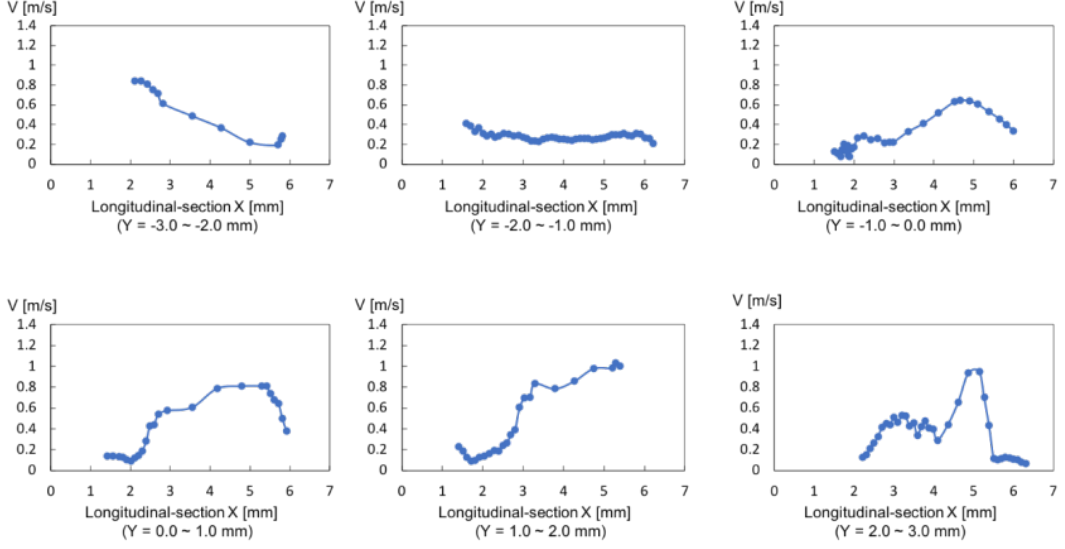
Figure 7. Flow velocity graph around the keyhole in the case of 160 A. Distribution of flow velocity around the ending part (X = 7.0~23.0 mm) in the case of 160 A is shown in Figure 8. The velocity increased from the ending part of the melted domain toward the keyhole, especially around X = 7~8 mm. At X = 7 mm, the velocity was very high. This is caused by the inward flow from the ending part of the weld pool until the keyhole and in downward flow from the upper side toward the lower side of the melted region. At Y = − 3.0~ − 2.0 mm region, the velocity was mostly unchanged along the weld pool surface. This case can be explained because the tracer particle was detected just within X = 12~16.5 mm. In this area, the frontward movement of tracer particles is stable with low velocity. The maximal velocity was about 1.2 ms − 1 at X = 8.0 mm in the case of Y = 1.0~2.0 mm. The minimal velocity was about 0.15 ms − 1 at X = 18.8 mm in the case of Y = − 1.0~0.0 mm.